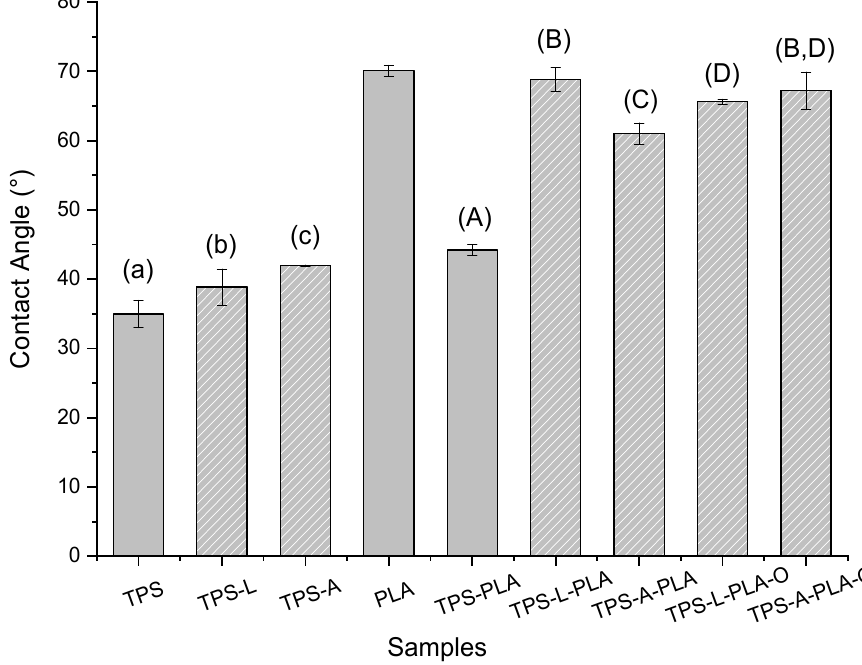
Figure 8. Average contact angle values and their respective standard deviations for modified TPS and blends of TPS/PLA. a–c; A–D: Different letters in the same column indicate significative differences from a set of means of each reprocessing group ( p < 0.05).